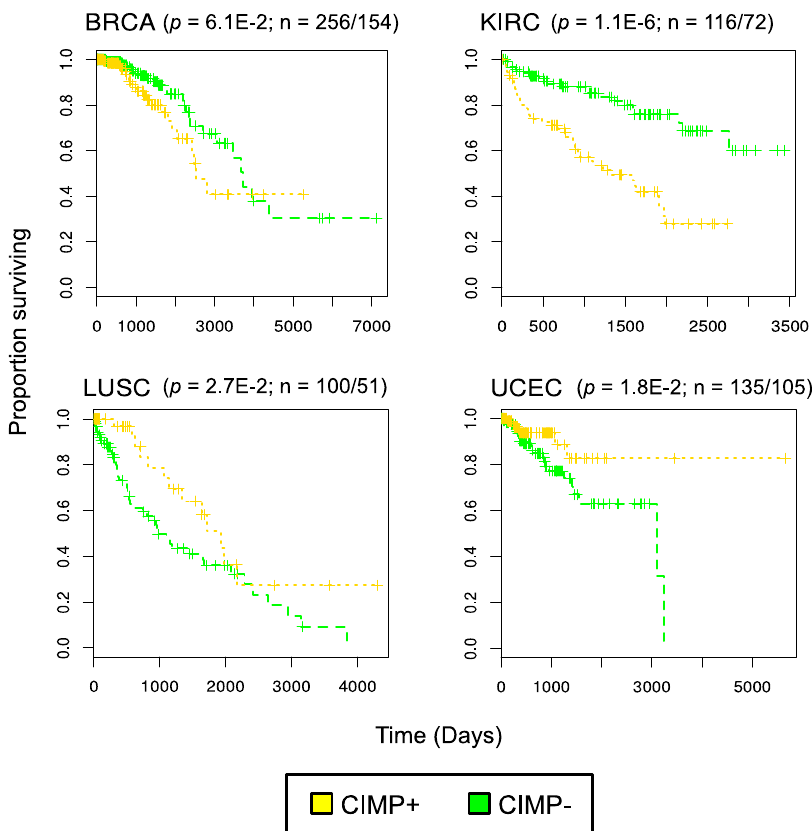
Figure 3. Survival curves in four cancer types based on CIMP: figure reproduced from [62] and published by BioMed Central. Data generated using The Cancer Genome Atlas clinical data for these cancer types. p values were determined using a log-rank test for survival differences. Ratio (n) indicates number of CIMP-/CIMP + samples.